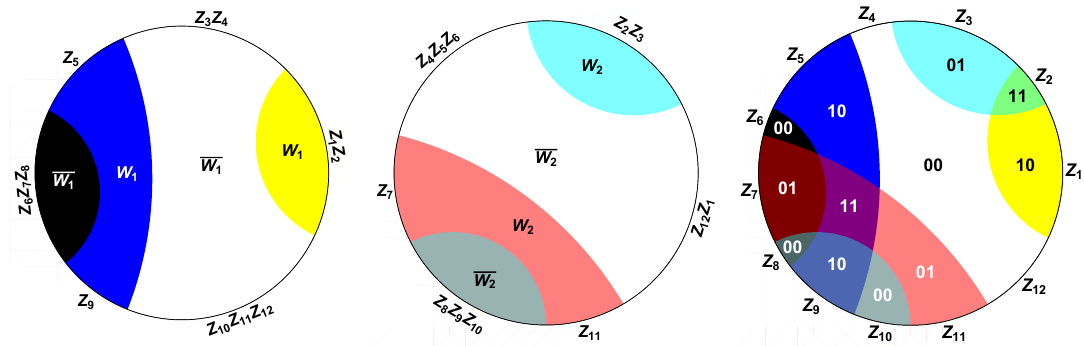
Figure 6 . Left and center panels: the division of regions W l and W l from (cid:12)gure 4 into connected components. We have W 1 = W blue W 2 = W 2white t W 2gray . Right panel: regions W ( ~x ) ~c , i.e., the various intersections of W c l For example, the purple interior region is W ((1 ; 1)) (blue ; red) = W blue adjacent to interval Z 3 is W ((0 ; 1)) (white ; cyan) = W 1white \ W cyan and I 2 = Z 2 Z 3 Z 7 Z 11